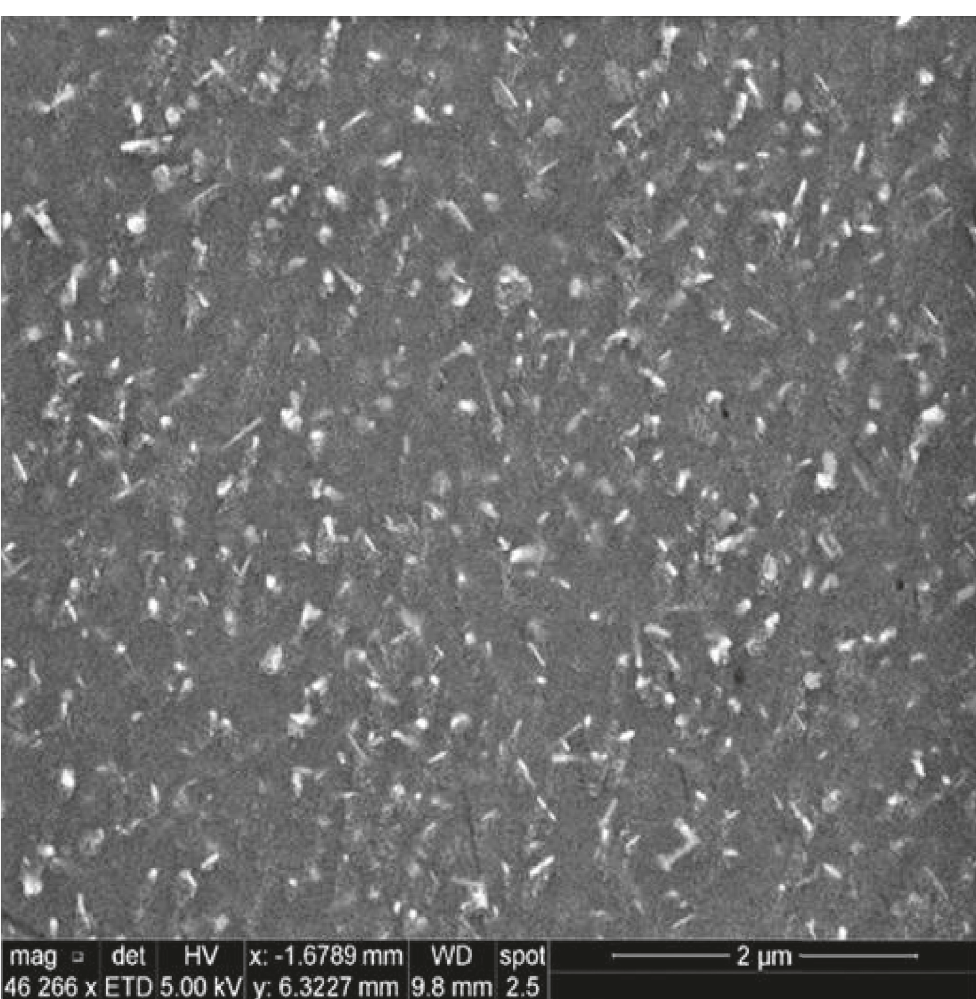
Figure 5: Micrograph of T7 heat-treated alloy B tested at 250 °